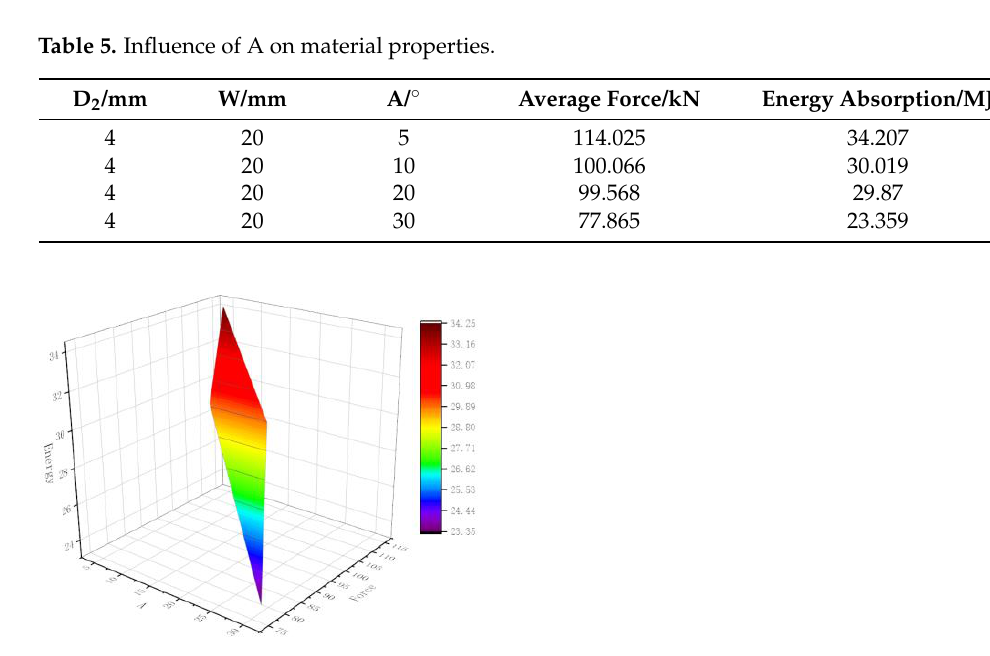
Figure 10. Three-dimensional figure of D – energy – force.